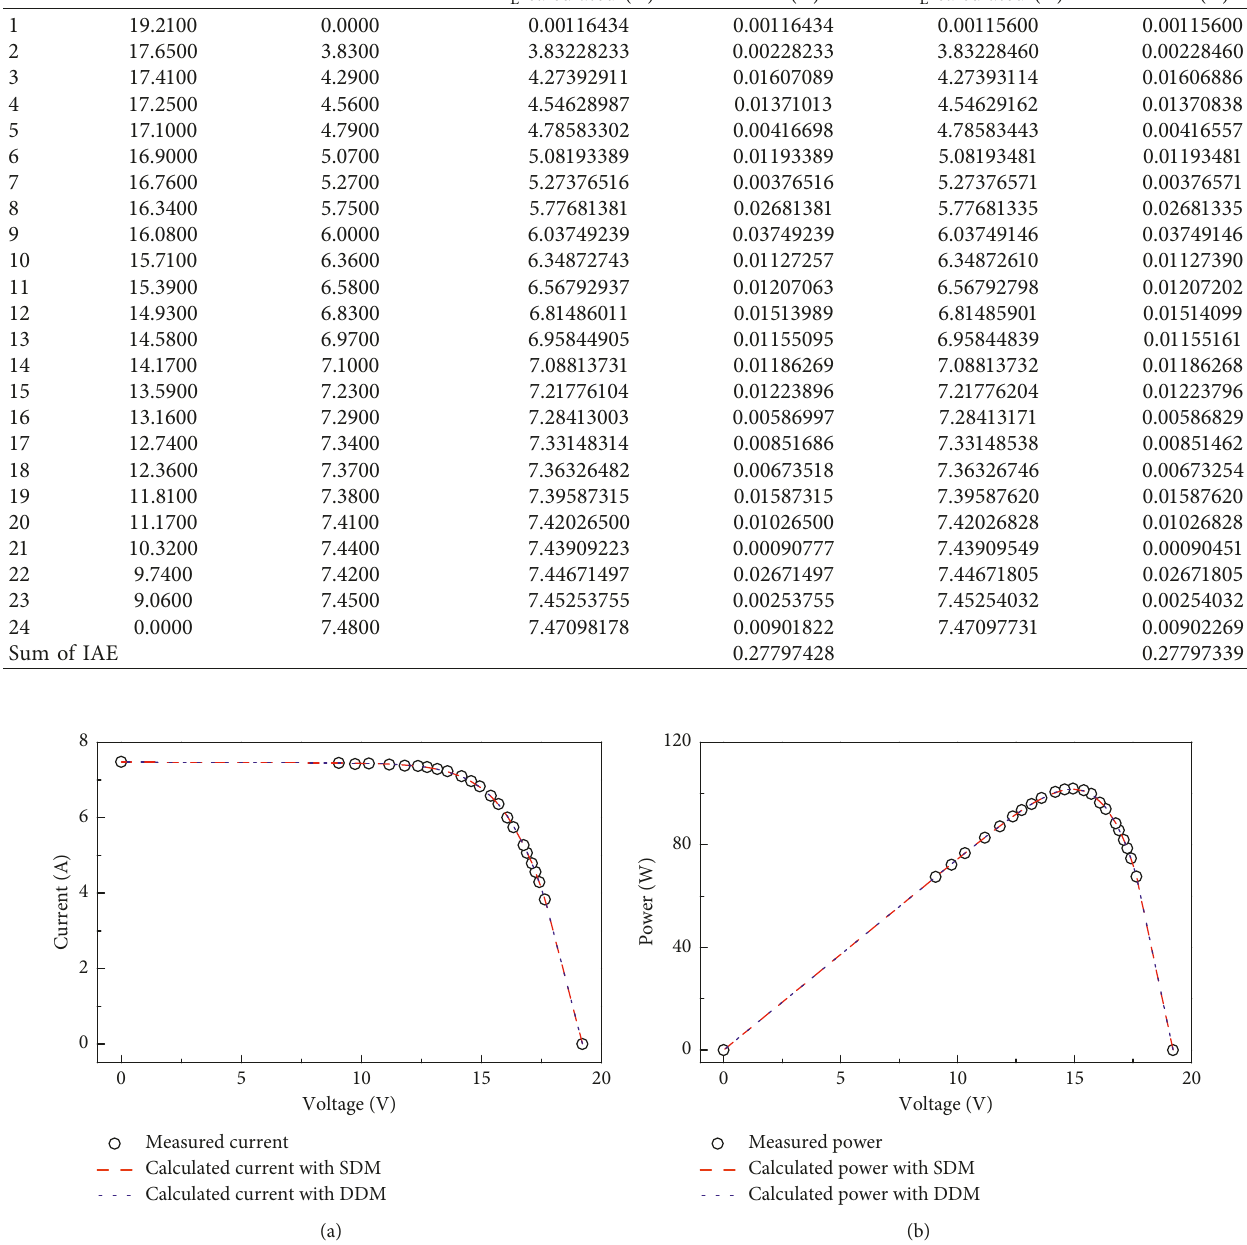
Figure 12: Comparison between the measured and calculated data achieved by SDO for the STP6-120/36 polycrystalline module. (a) I-V characteristic; (b) P-V